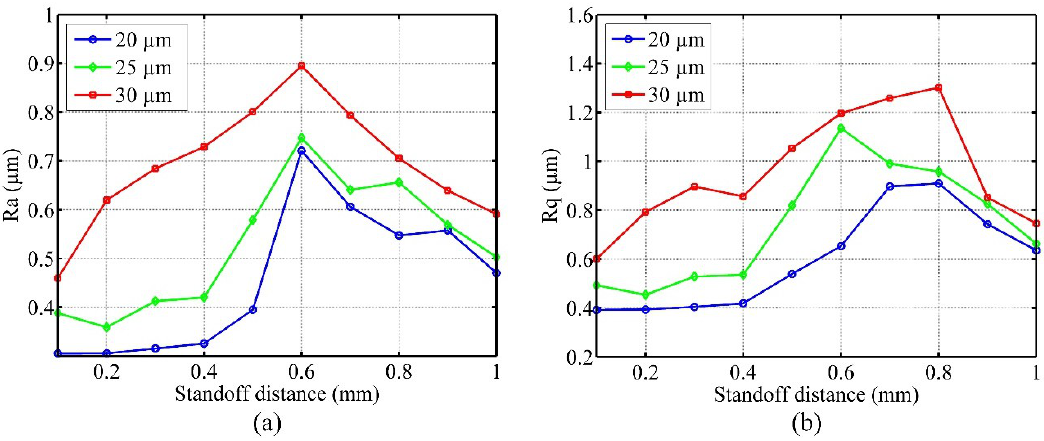
Figure 5. ( a ) R a and ( b ) Rq at different standoff distance and different vibration amplitudes.